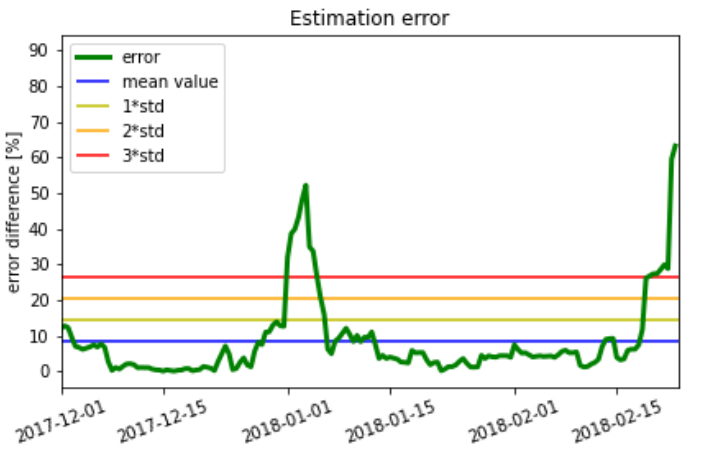
Figure 7. The time history of the difference between Tar—Ref normalized mean absolute error (NMAE) with different statistical